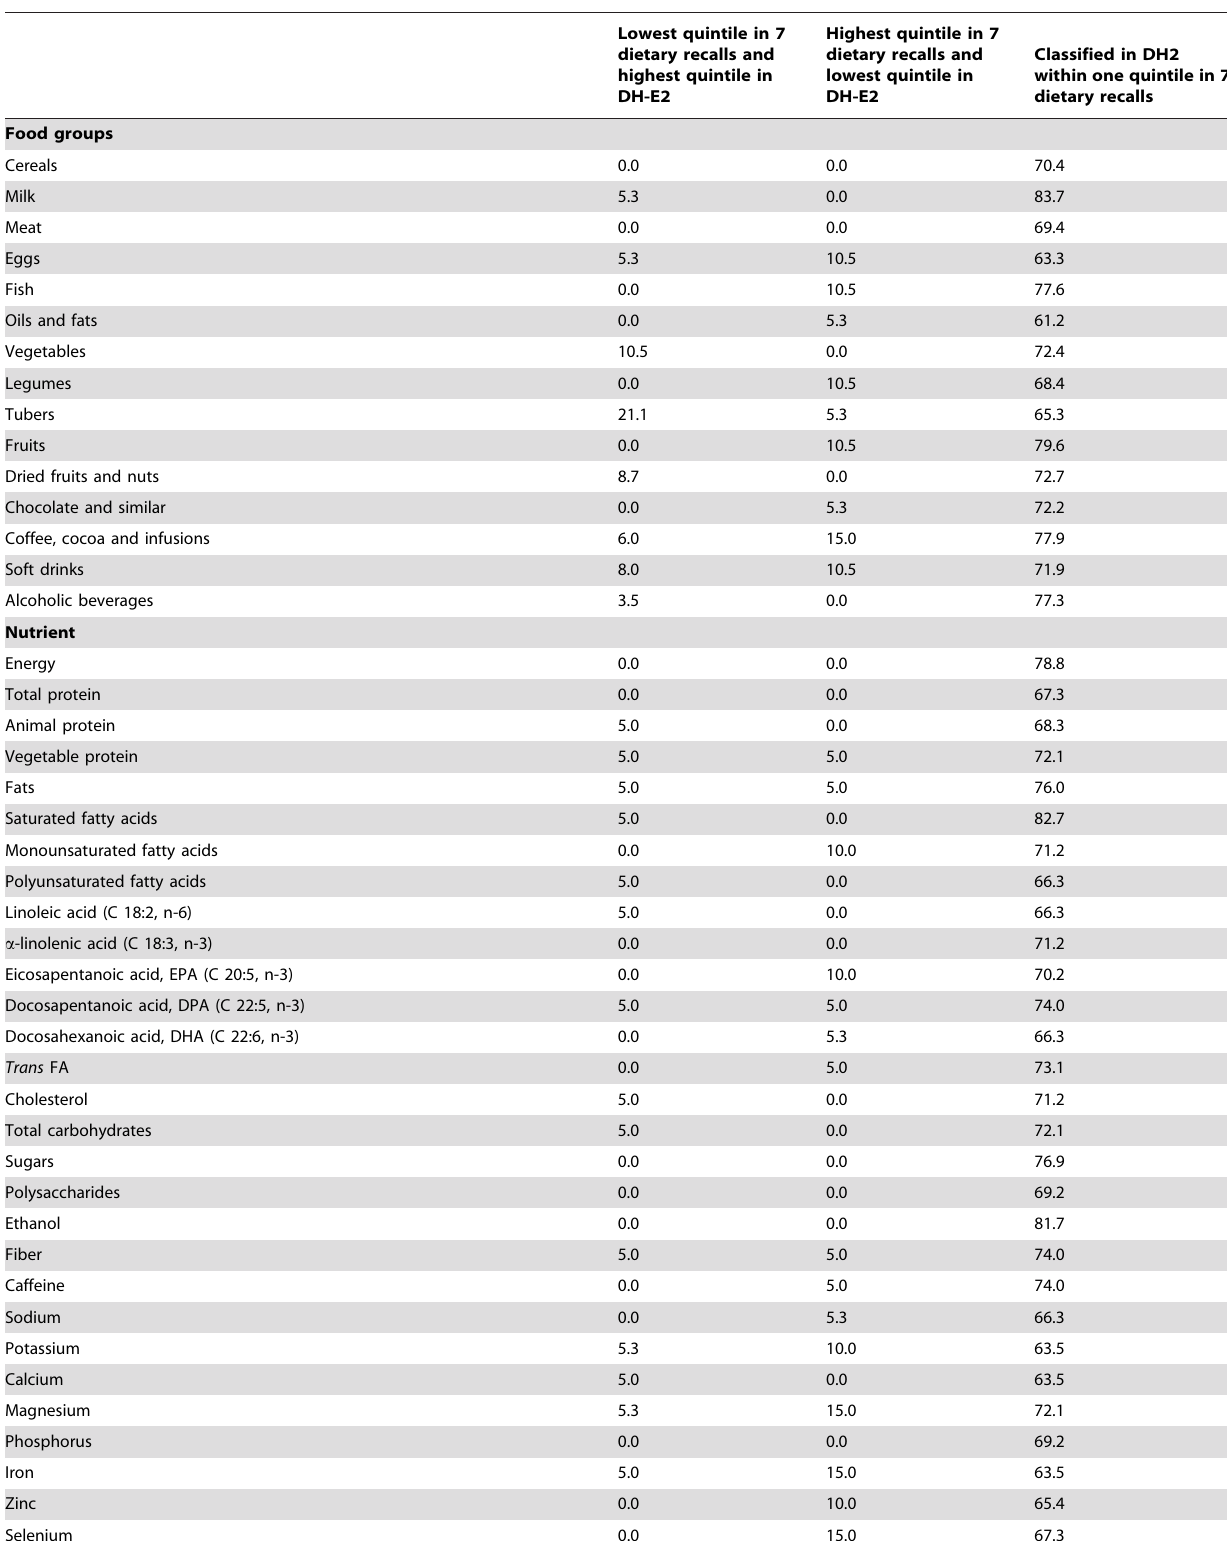
Table 4. Cross-classification of subjects by food and nutrient intake estimated with DH-E2 (at 12 months from baseline) and mean of seven 24-hour recalls during one